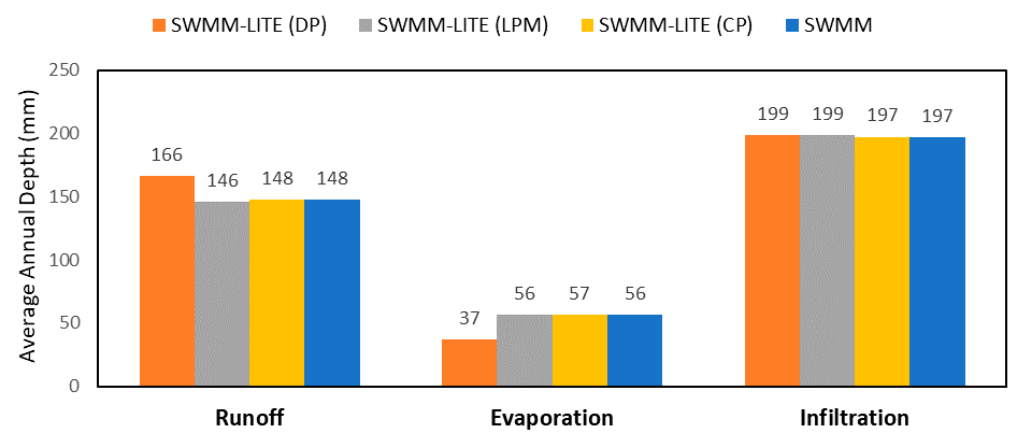
Figure 2. Hydrologic outputs for SWMM-Lite variations of Default Parameters (DP), Limited Parameter Modification (LPM), and Consistent Parameters (CP) compared to SWMM.